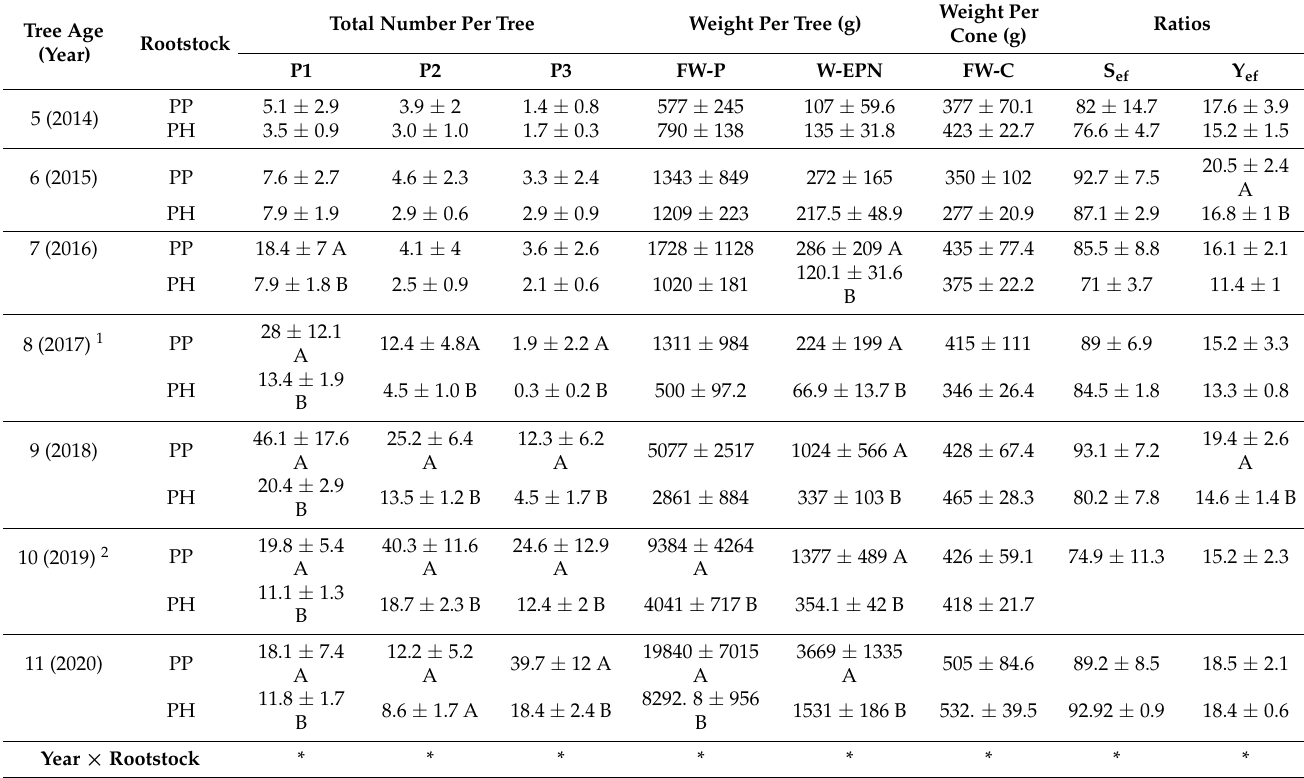
Weight Per Cone (g)